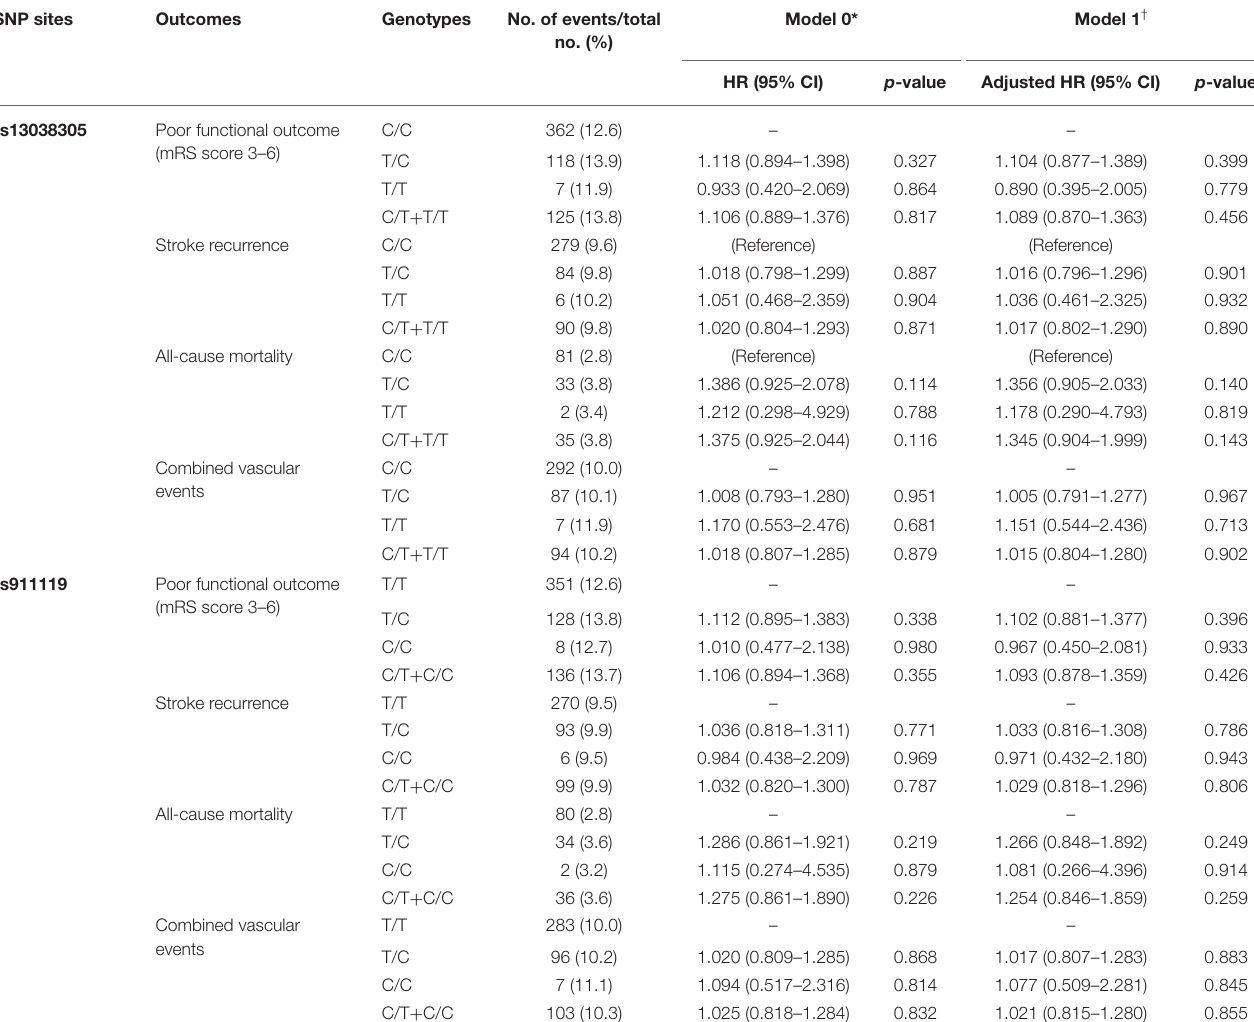
TABLE 4 | Clinical outcomes in different CST3